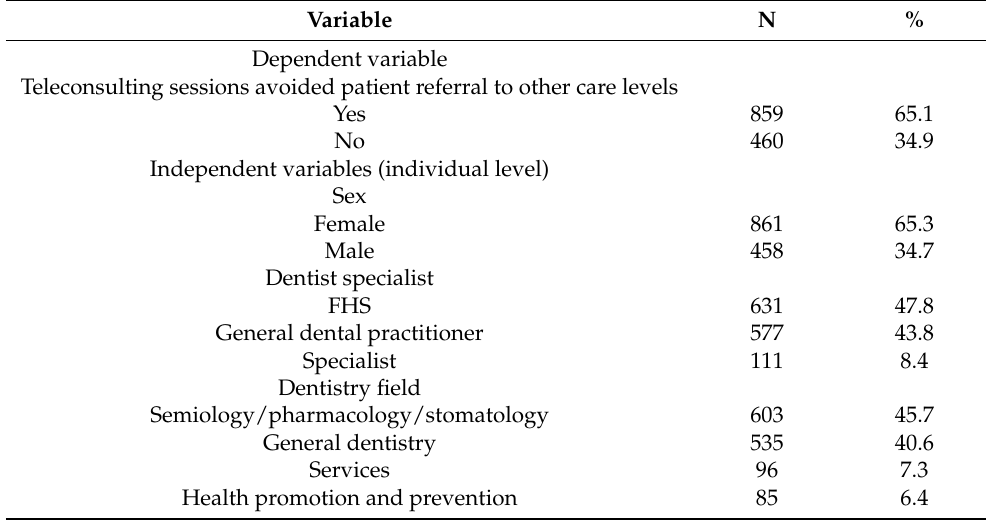
Table 2. Descriptive analysis of individual variables from dental teleconsulting sessions.